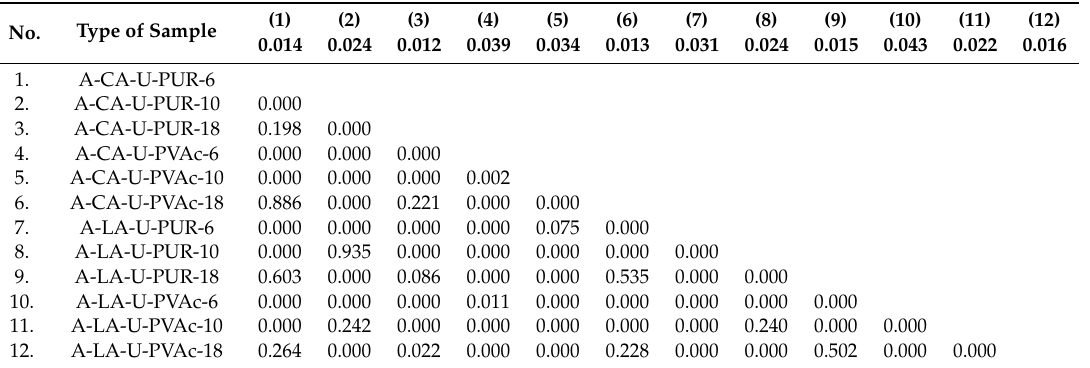
Table 20. Comparison of the e ff ects of individual factors using Duncan’s test on the coe ffi cient of bendability ( K bendC ) for aspen and NWC on top.